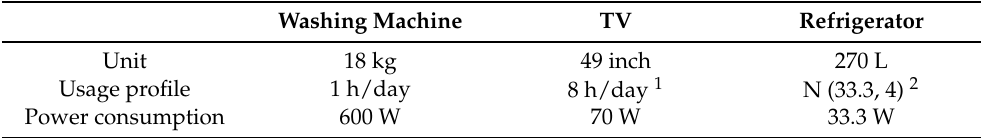
Table 2. Home appliances energy consumption